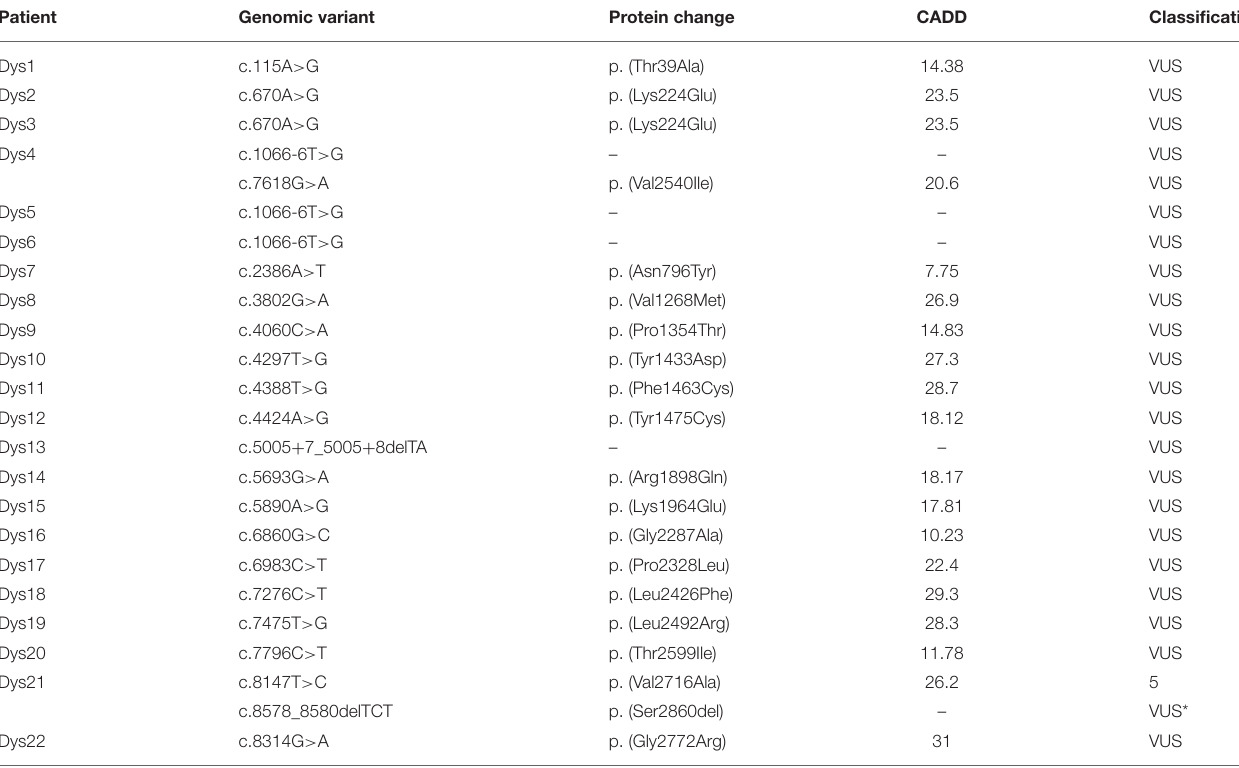
TABLE 1 | Rare variants in the ATM gene among the 373 dystonia patients detected with smMIPs.